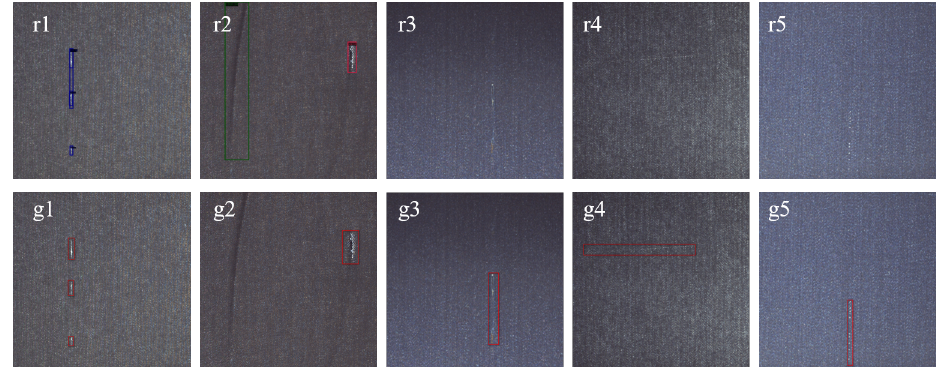
Figure 15. Some examples of false detections, where the first row shows the detection results and the second row shows the ground truth. Overdetection occurs in r1, g1, r2 and g2; and missed detection occurs in r3, g3, r4, g4, r5,